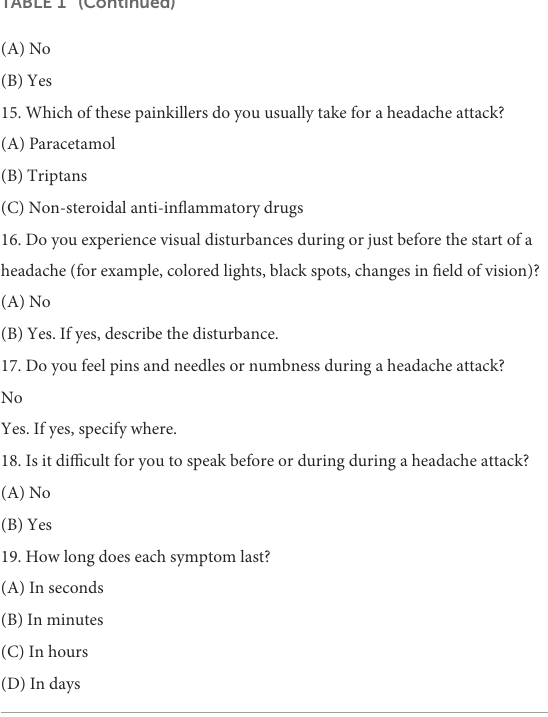
TABLE 2 Headache questionnaire part 2: During